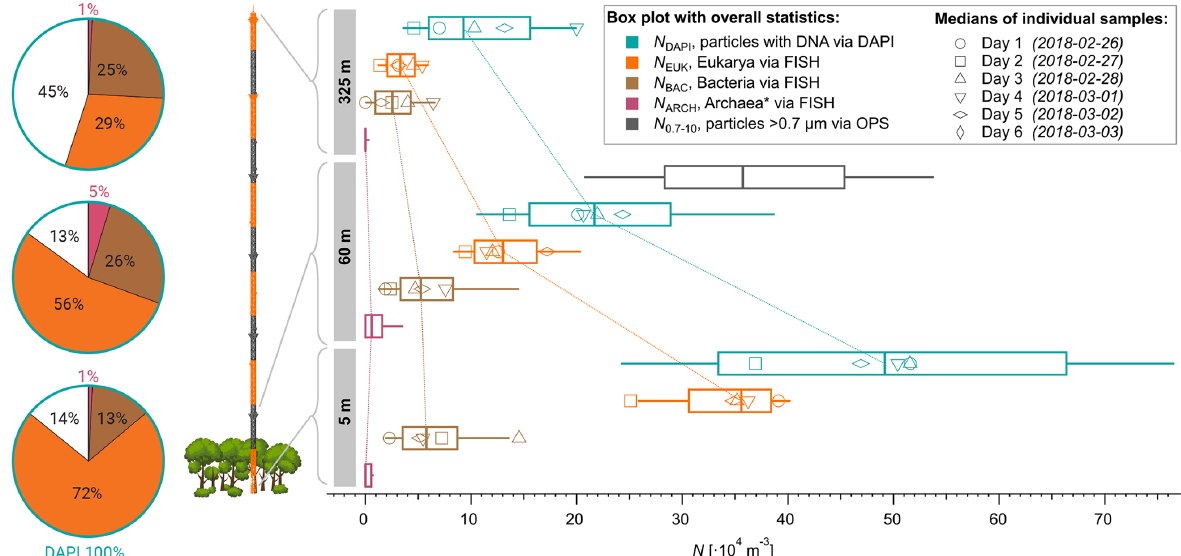
Figure 3. Height profiles of aerosol number concentrations observed at 5, 60, and 325m above ground at the ATTO-tower. The median concentrations of all daily samples are displayed as vertical box and whisker plots with 25 and 75 quartiles as boxes and 10 and 90 percentiles as whiskers. Daily median values are shown as markers according to the legend. Bioaerosols were quantified with FISH and DAPI staining. The total aerosol number concentration at 60m was determined by an optical particle sizer (OPS) in the corresponding size range.